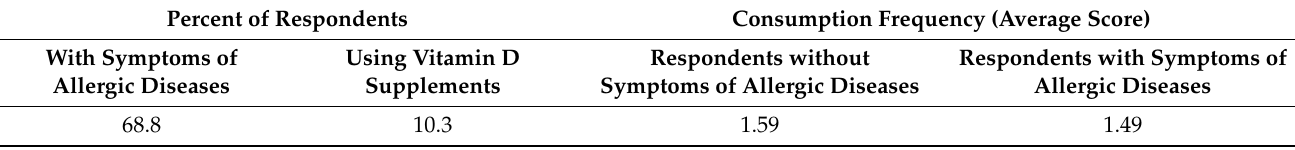
Table 2. Results of the analysis of the data of questionnaire